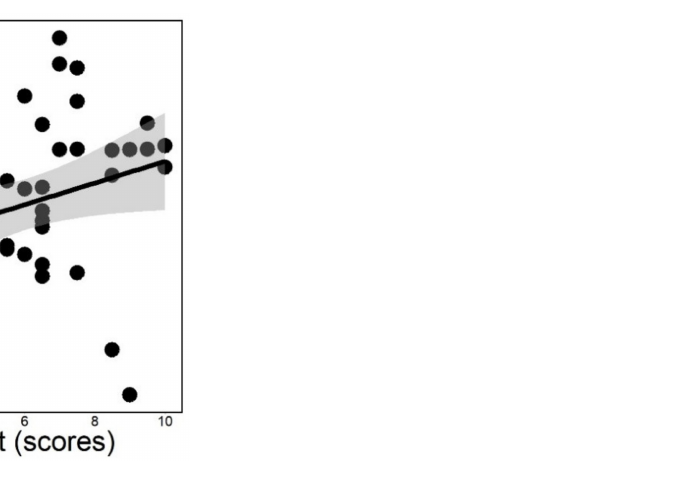
Figure 2. Relative duration of NREM plotted as a function of attachment scores measured in the Strange Situation Test. Gray area: 95% confidence interval from standard error.